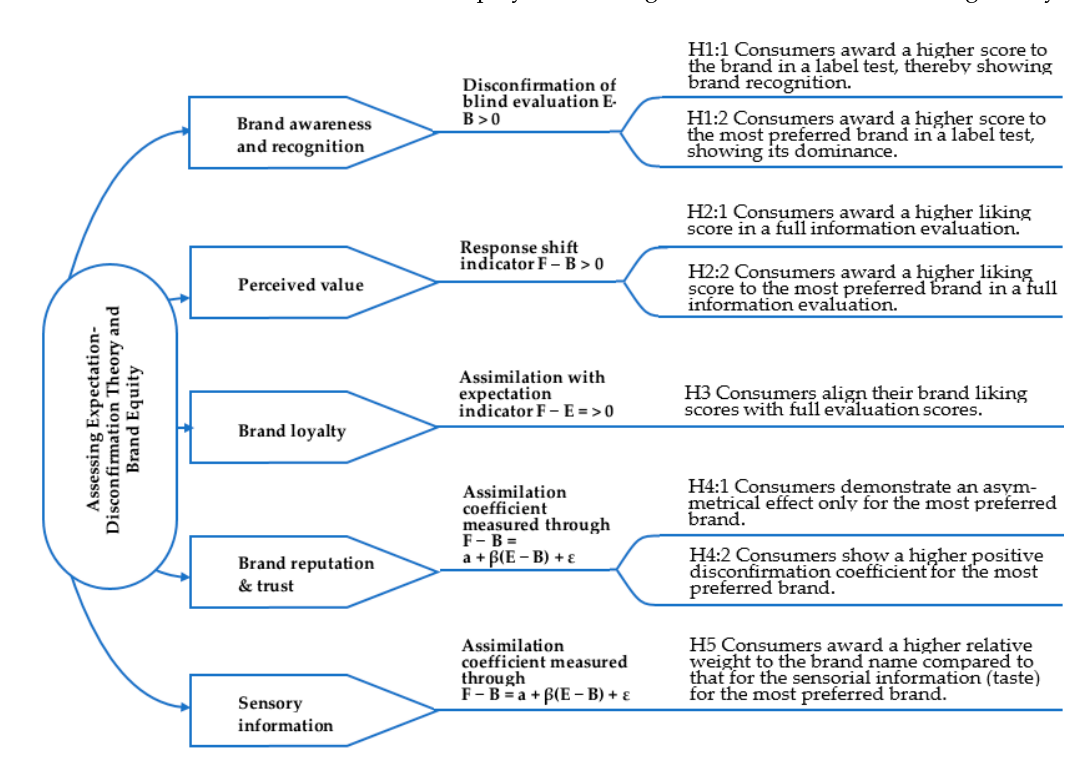
Figure 1. Mapping brand equity with Expectation–Disconfirmation Theory. Note: Expectation score (E); Blind test score (B); Full information test score (F); B1, B2, B3, B4: conducted brands; α : Level of assimilation (proportion of the response shift over the degree of incongruence); β , ε : func- tion coefficients. Source: Authors’ construction.